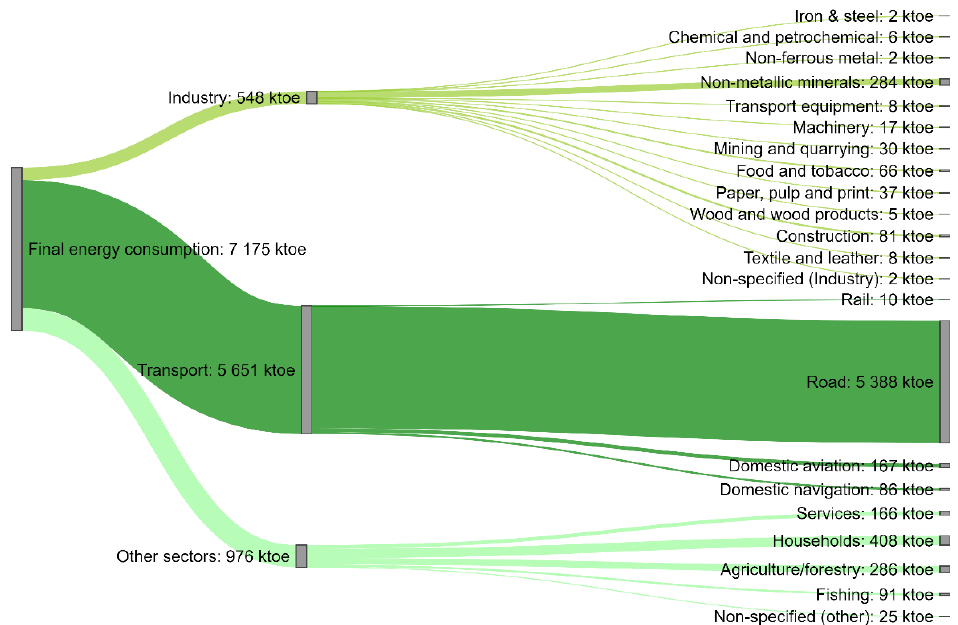
Figure 23. Portuguese energy balance flow for oil and petroleum products vector in final energy consumption–2019 data (adopted from Eurostat data).